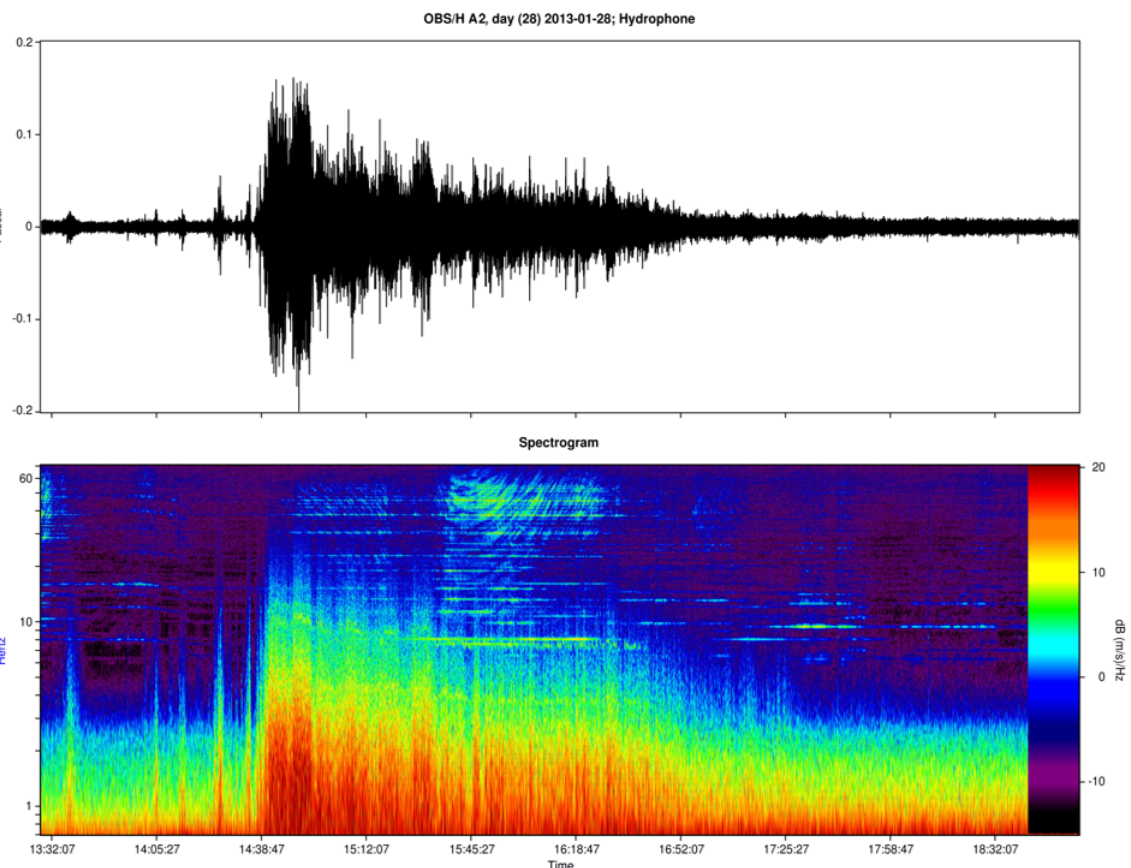
Figure 8. Example of high frequency event recorded by the OBS/H located on the Graham Bank. Top = pressure signal, Bottom = relative